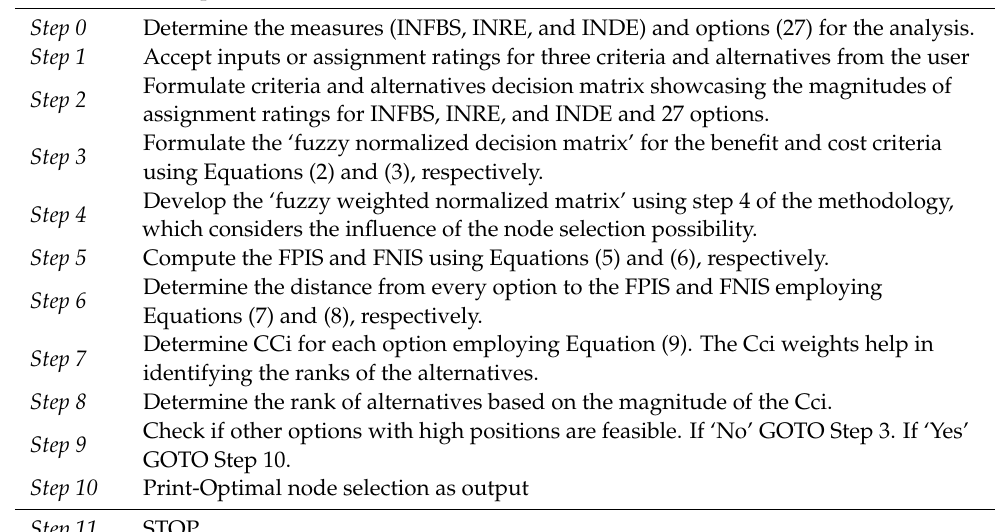
Algorithm 1. Proposed